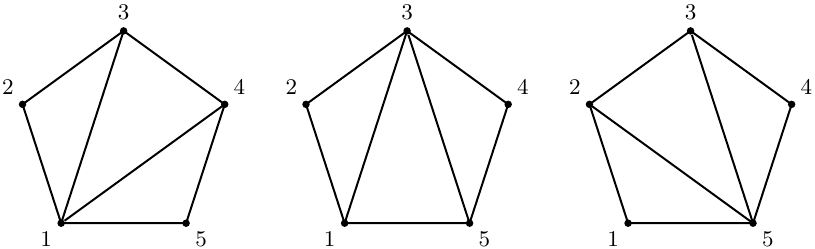
Figure 17. The first triangulation of the 5 -gon corresponds to the parameterization in eq. (A.3). Each minor in eq. (A.3) corresponds to an edge. The remaining triangulated 5 -gons correspond to the mutation pattern that leads to h 2 , 5 i